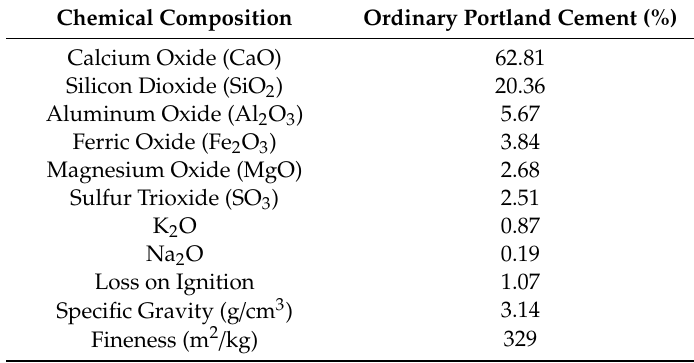
Table 1. Chemical compositions and physical properties of Portland ordinary